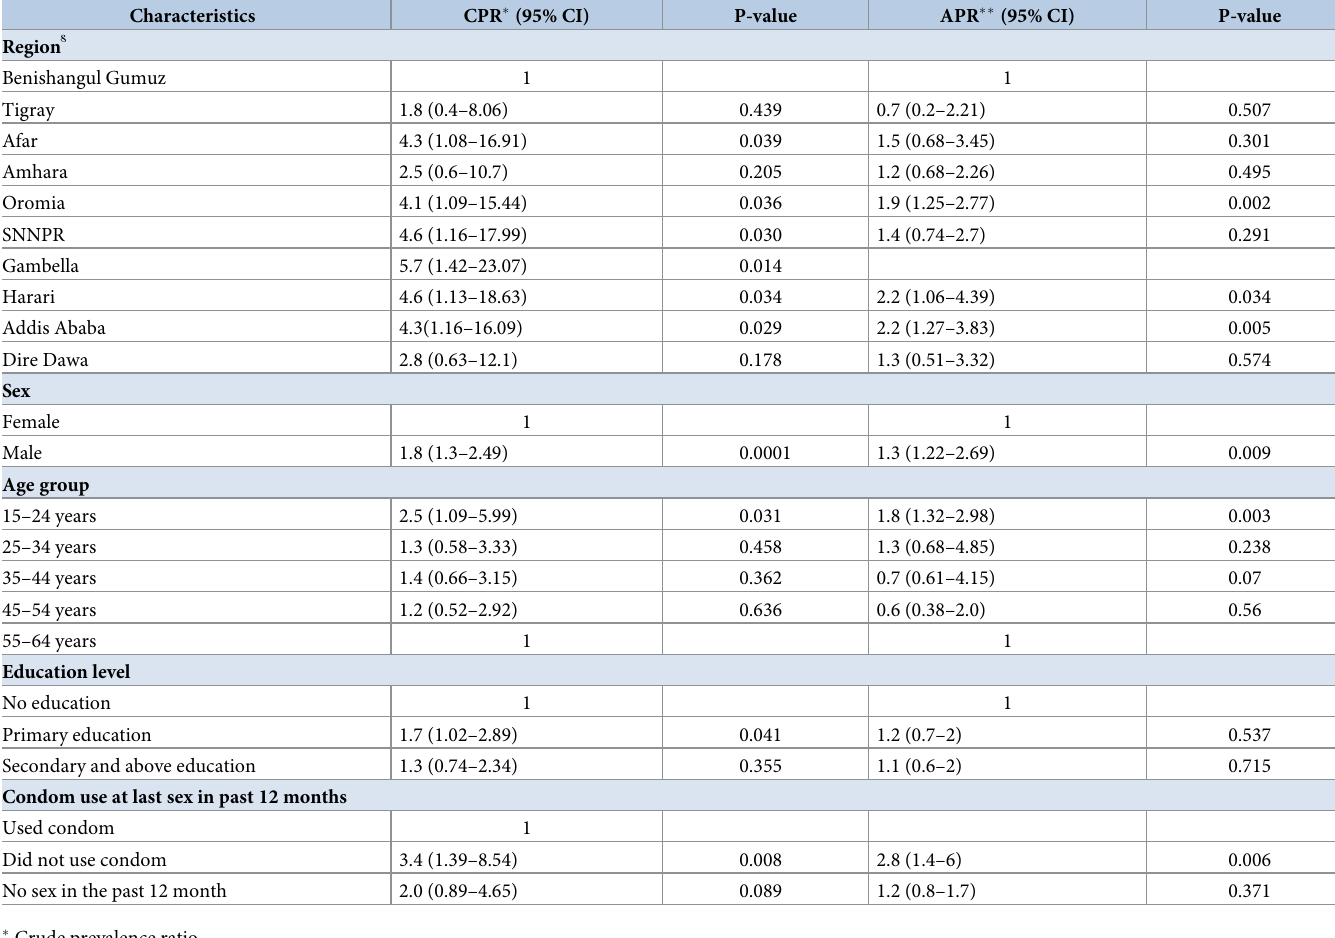
Table 3. Factors associated with weighted unawareness status among HIV-positive participants aged 15–64 years, EPHIA 2017/2018.